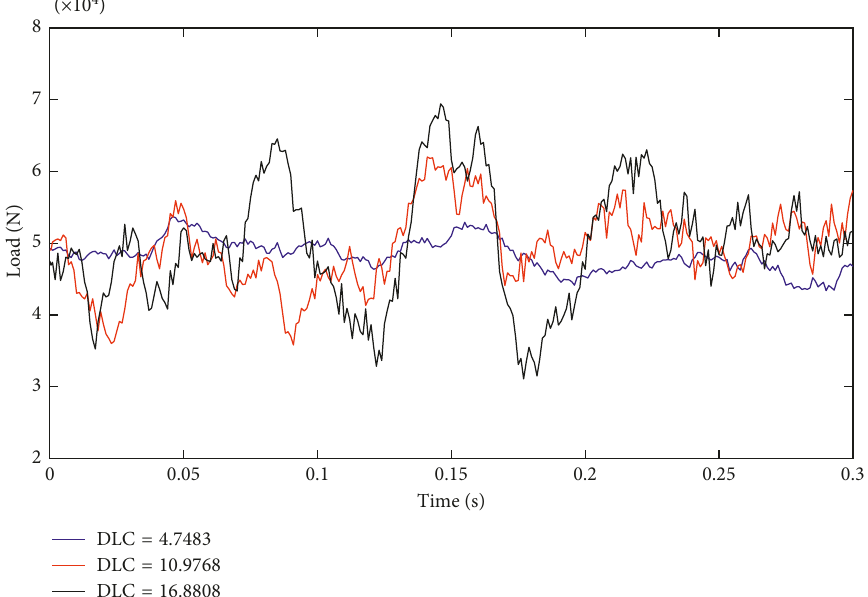
Figure 9: The random dynamic load corresponding to different